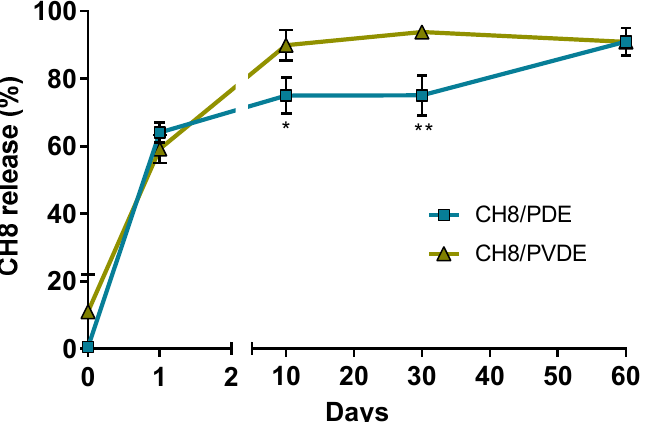
Figure 4. In vivo drug release. Mice were injected in the ear pinnae with 30 μg of CH8 loaded in either CH8/PDE or CH8/PVDE. At the indicated time points, mice were euthanized for quantifica- tion of CH8 in the ear tissue by HPLC-UV. Means ± SEM ( n = 5). * p < 0.05, ** p < 0.01.